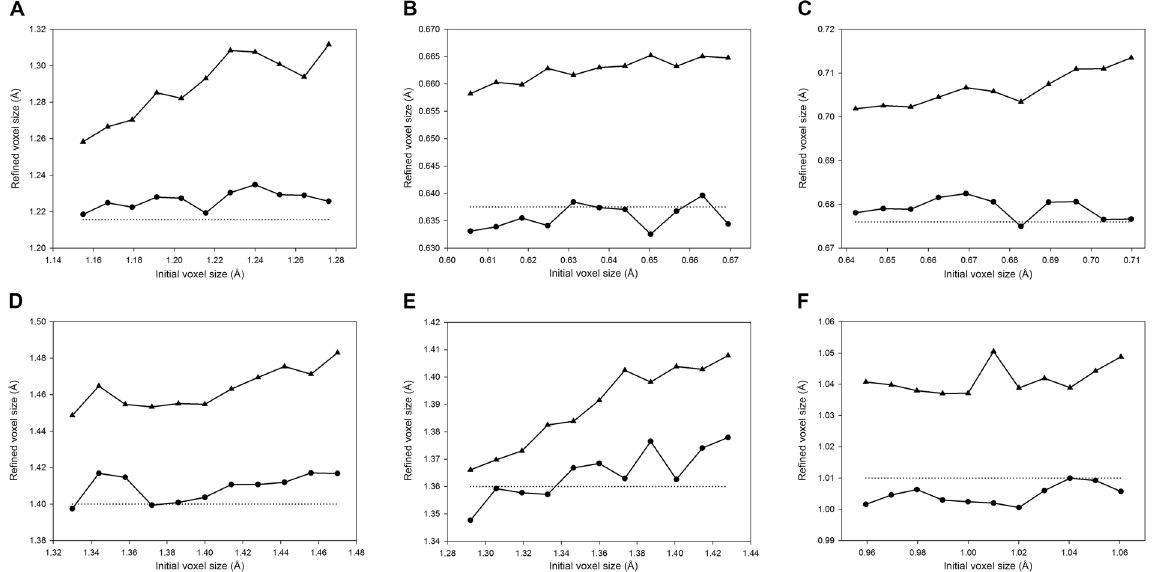
Figure 4. Results of voxel size refinement. The test data sets are: EMD8117 ( A ), EMD6630 ( B ), EMD3297 ( C ), EMD3061 ( D ), EMD3388 ( E ) and EMD6534 ( F ). RESOLVE template and our template (2.5 Å) were used in the refinement and are depicted as triangles and circles, respectively. The dotted line represents the correct voxel size of the map (from